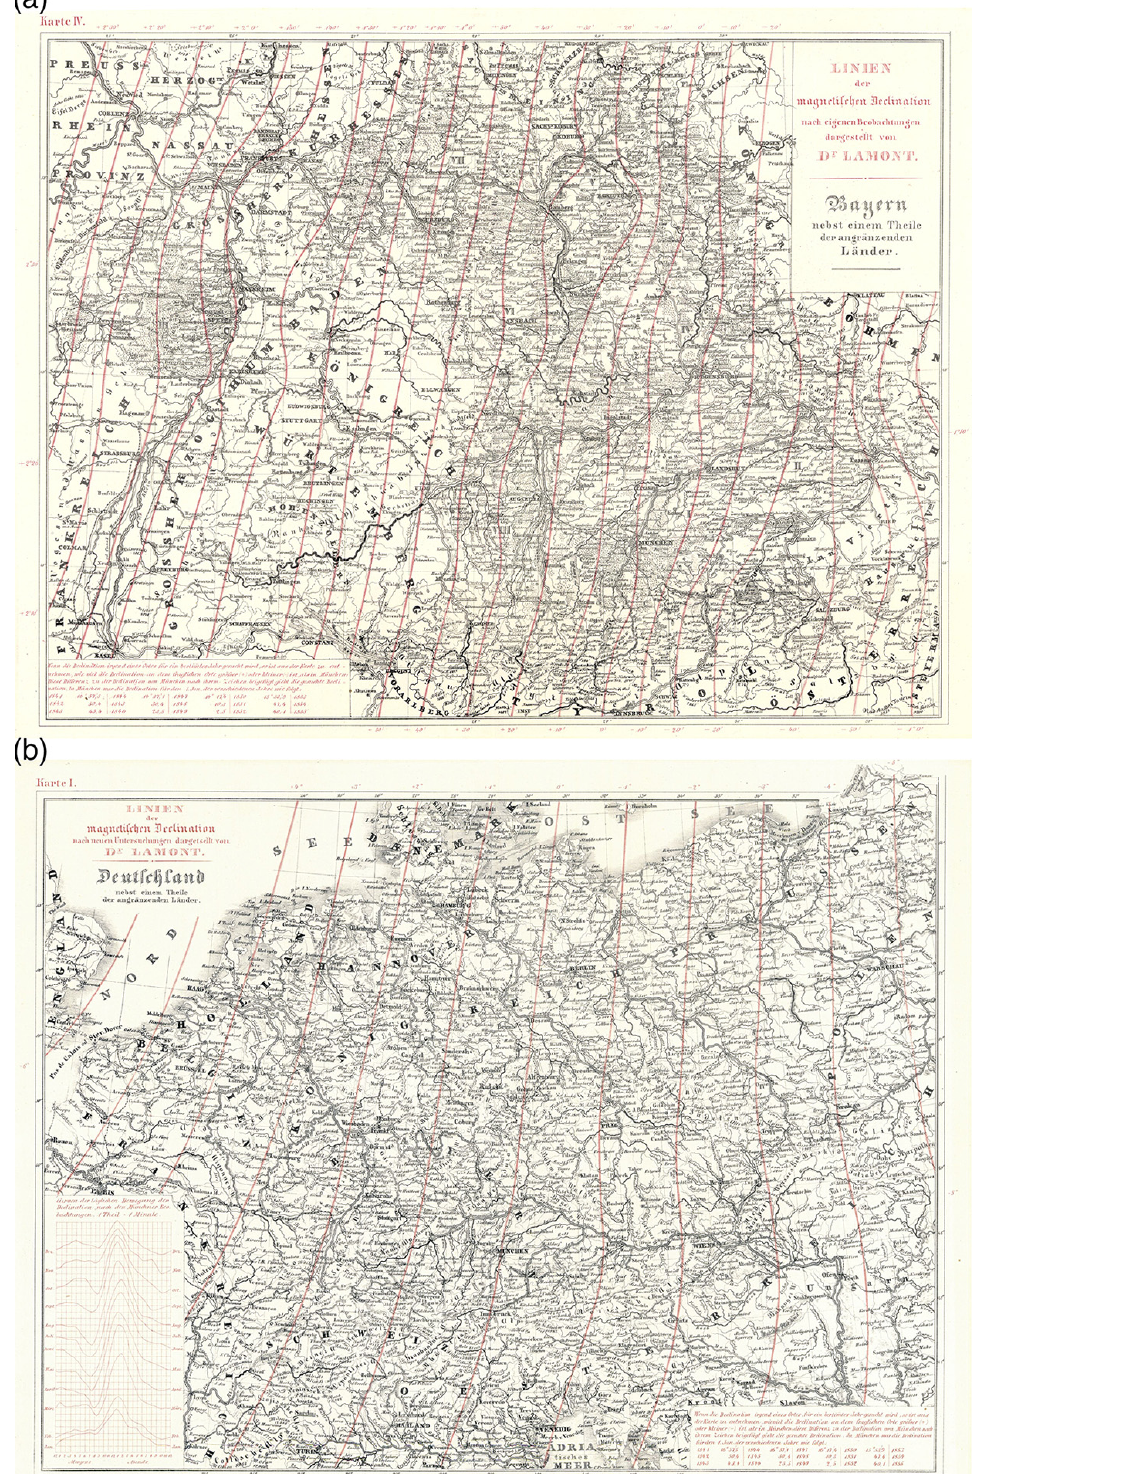
Figure 6. Maps showing the declination reduced to 1 January 1850 in Munich where D had a value of − 15 ◦ 53 . 9 (cid:48) E. (a) Southern Germany (Lamont, 1854a). The eastern declination decreases towards the east. Each isoline represents a change of 10min. (b) Central Europe (Lamont, 1854b). Each isoline represents a change of 1 ◦